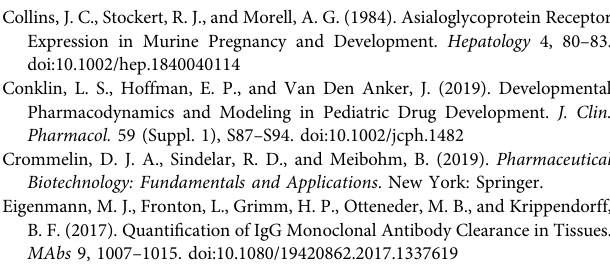
TABLE 1 | Examples of receptor systems affecting the pharmacokinetics of therapeutic proteins with unknown ontogeny. Receptor system Tissues Asialoglycoprotein receptor